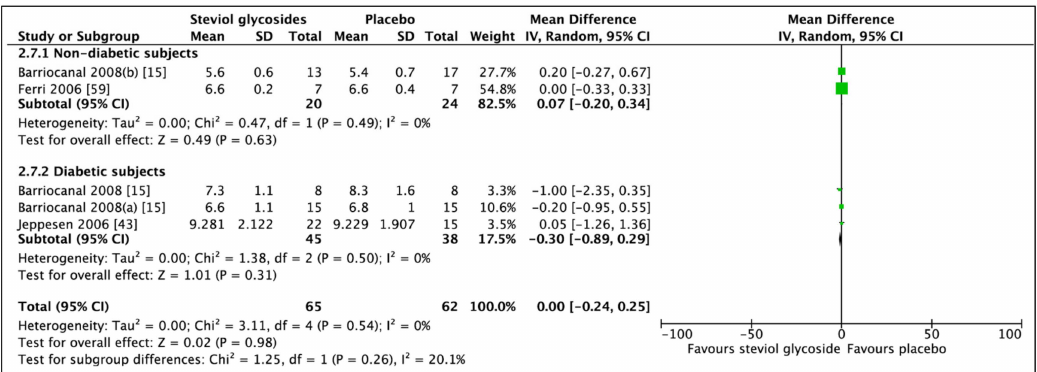
Figure 11. E ff ect of SGs on triglycerides (TAGs, mg / dL) CI: confidence interval; MD: mean di ff erence; RCTs: randomized controlled trials; SD: standard deviation.